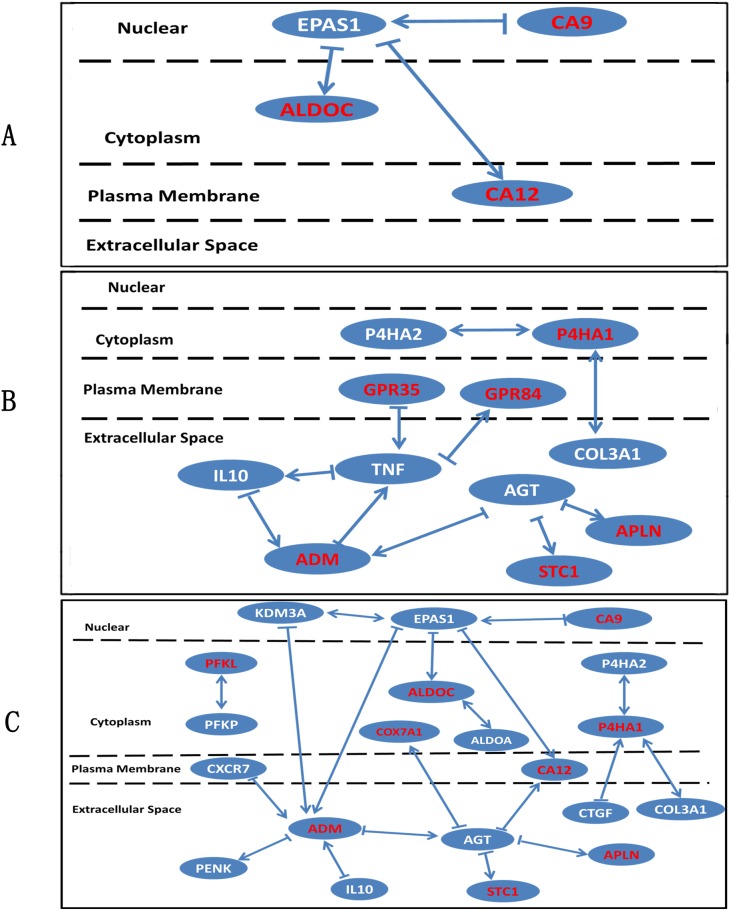
Analysis of interactions among differentially expressed genes in four sets.Interactions of DEGs were mined by iReport (http://www.ingenuity.com/products/ireport) on the basis of Ingenuity knowledge base. The arrow points downstream. The double sided arrow indicated that interaction of the two genes were bi-directional. The red font genes were those verified by PCR, and the write font ones were DEGs tested by microarray. The dashed lines partitioned different regions of osteocyte cell and genes then presented as their cellular locations. (A) μ-g v.s. control, (B) 2-g v.s. control, (C) μ-g v.s. 2-g.